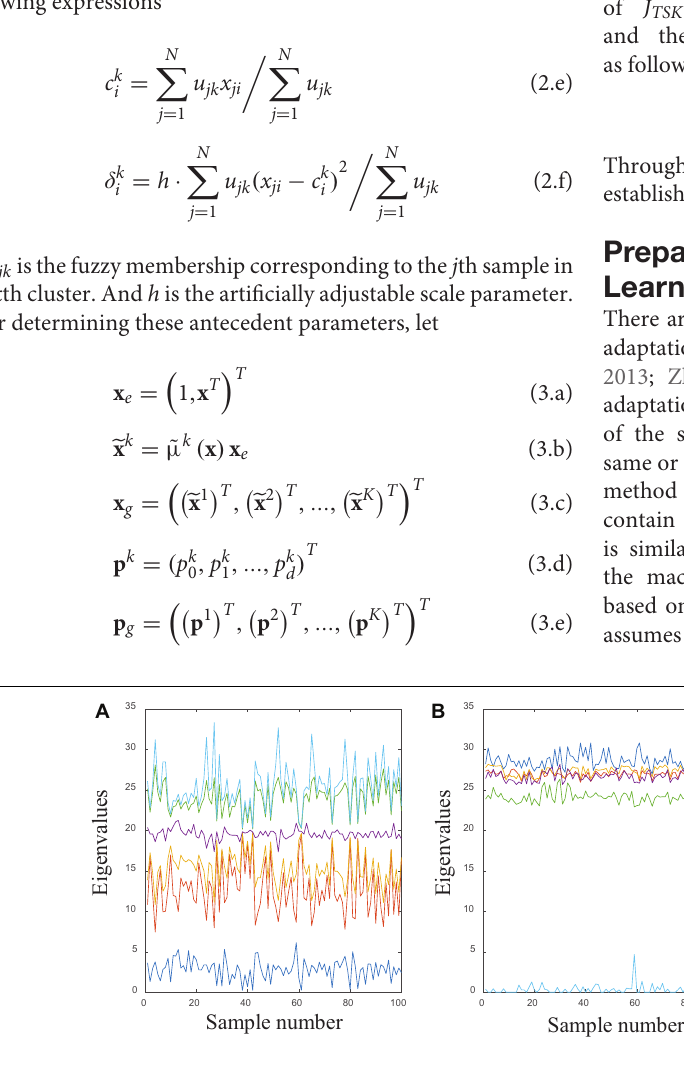
FIGURE 4 | (A) The samples of group A processed through WPD; (B) the samples of group A processed through STFT; (C) the samples of group A processed through